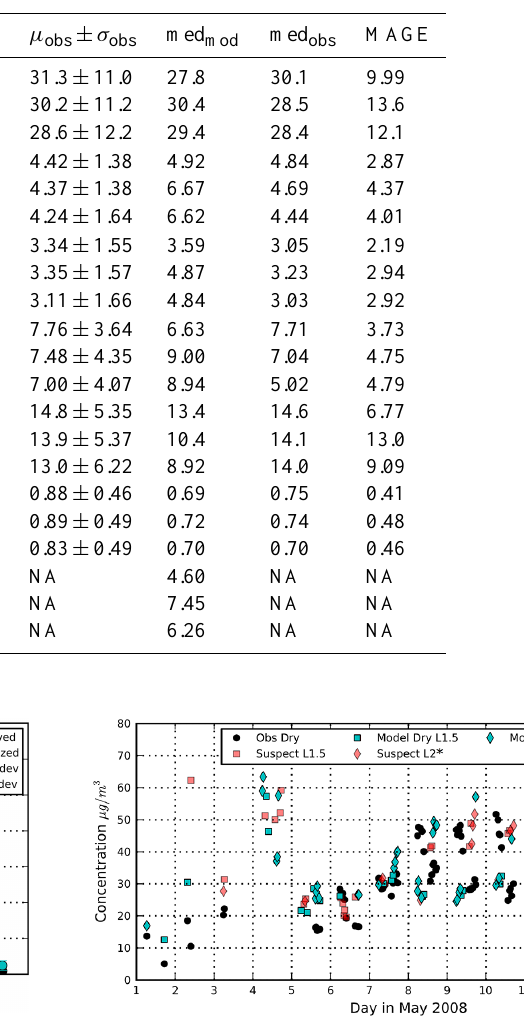
Table 6. Mean (column-average) modeled (µ mod ) and mean observed ( µ obs ) (near-surface) mass concentration (µgm − 3 ) together with corresponding standard deviations ( σ ), modeled and observed medians (med mod and med obs ) and mean absolute gross error (MAGE) for the non-suspect (N-S) data, L1.5 and the L2 ∗ data during the first half of May 2008. NB: NA is given when there are no observational data available.